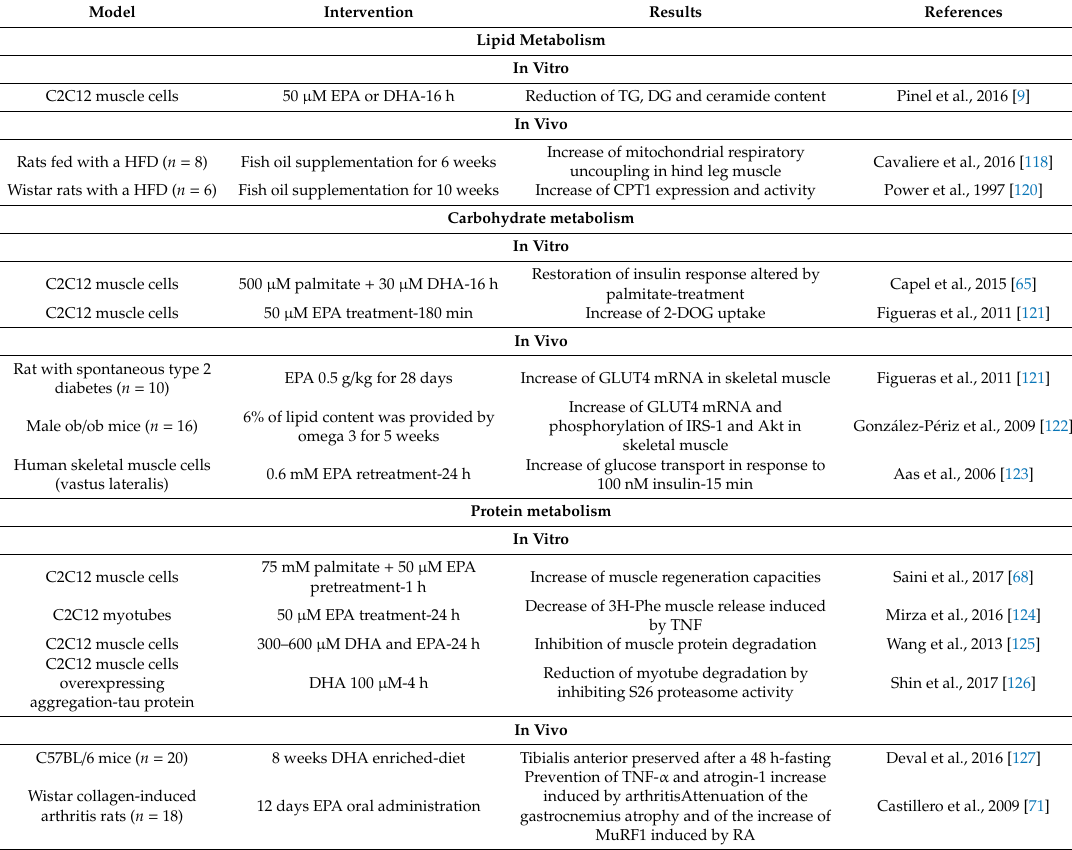
Table 1. Omega 3 and muscle metabolism.